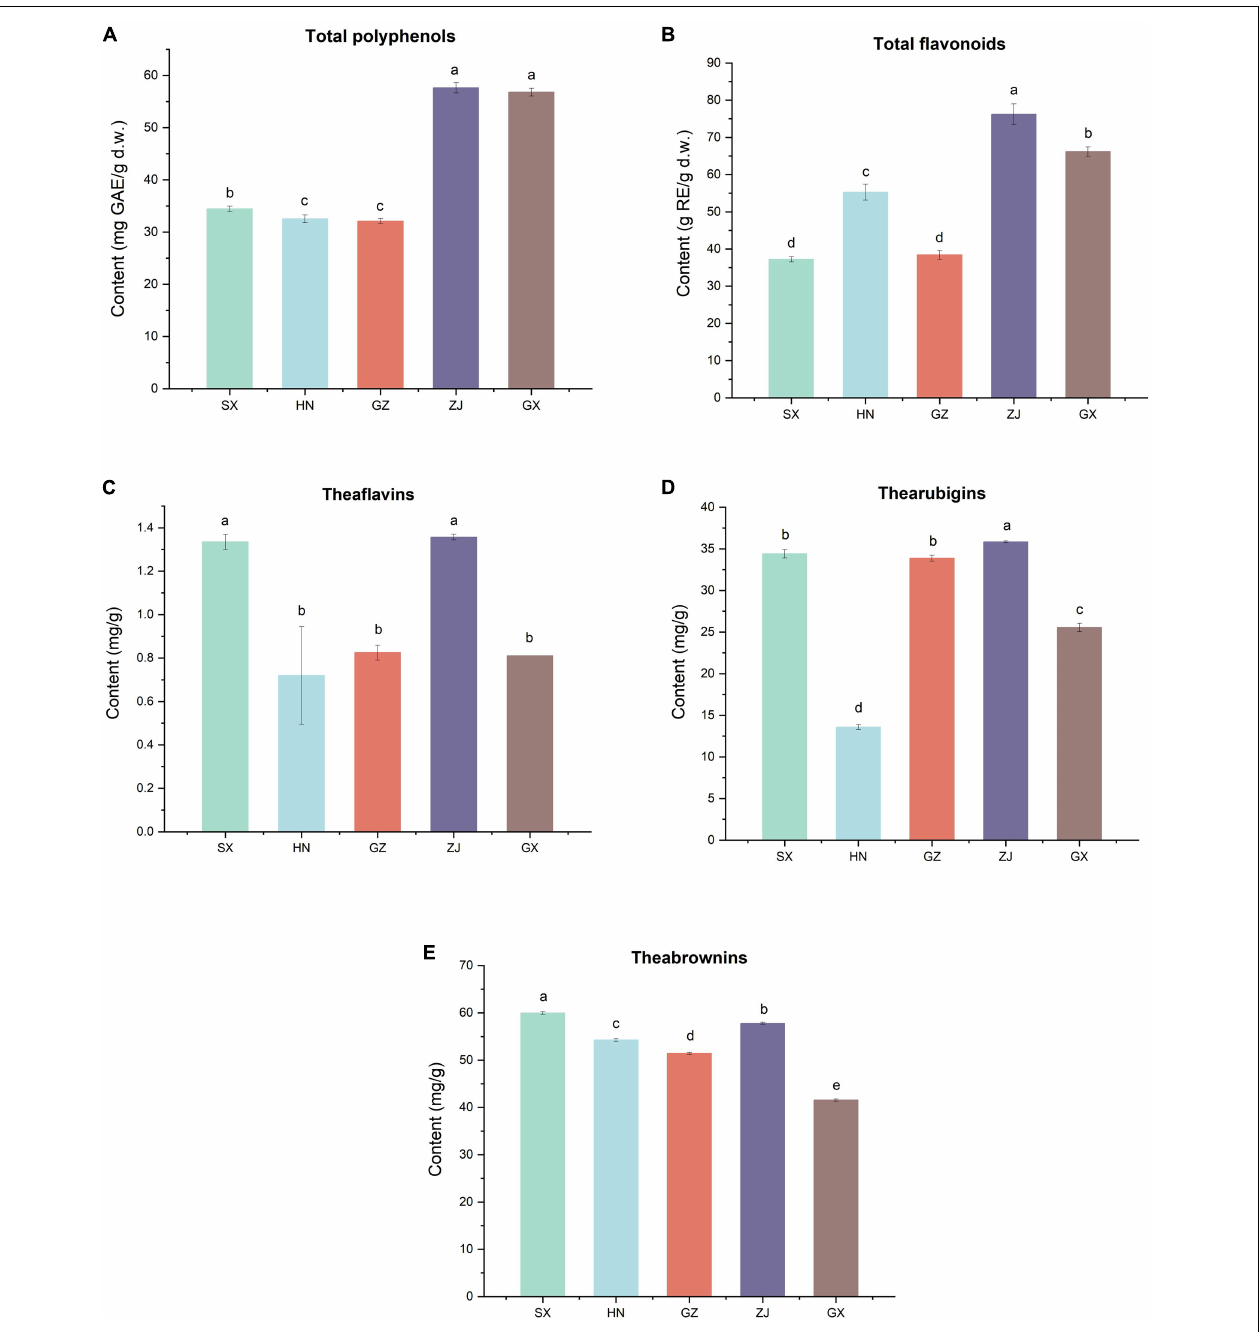
FIGURE 5 | Contents of (A) total polyphenols, (B) total flavonoids, (C) theaflavins, (D) thearubigins and (E) theabrownins of five Fu brick teas in different